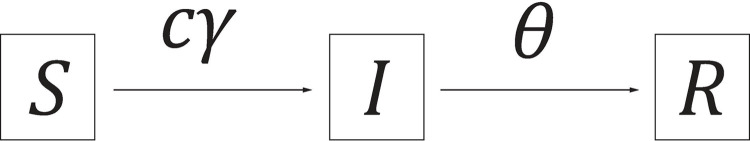
SIR conceptual diagram.Boxes represent susceptible, infected, and recovered compartments, and directed arrows represent the flow of individuals between these compartments with the rate of flow being controlled by the contact rate, c, the probability of infection, γ, and the recovery rate, θ.